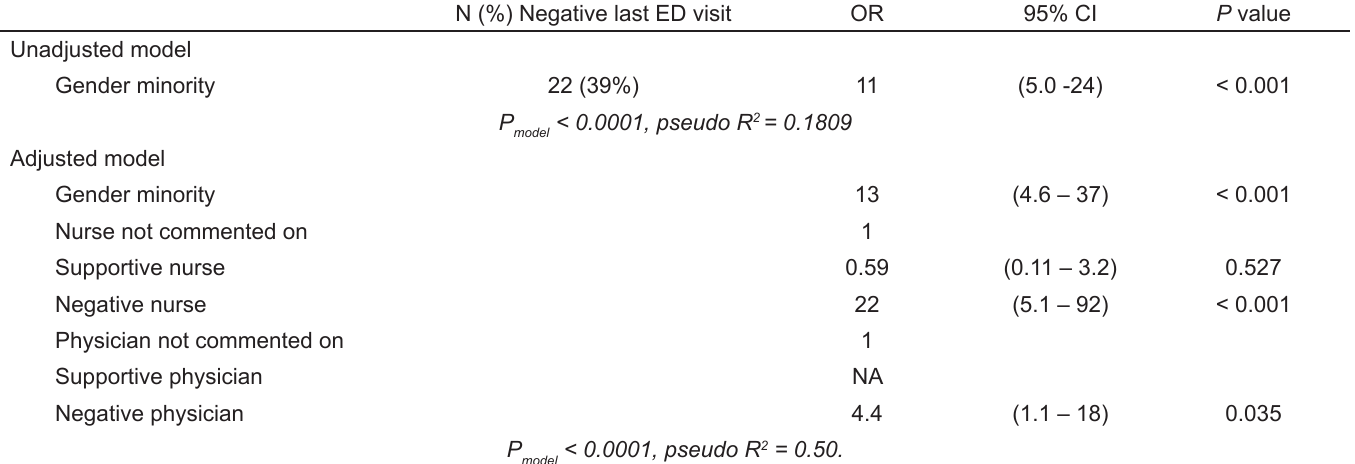
Table 5. Odds of reporting last emergency department experience as negative by patient and ED factors.